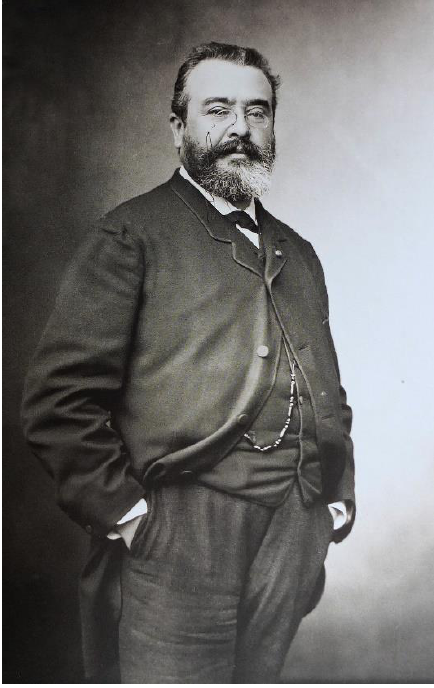
Figure 1. Photograph showing Adrien Achille Proust (1834 – 1903) taken on 26th November 1886. Image in the public domain from Wikipedia. Available online at: https://en.wikipedia.org/wiki/Adrien_Proust#/media/File:Adrien_Proust_1834 – 1903.jpg (last accessed on 27 February 2022).